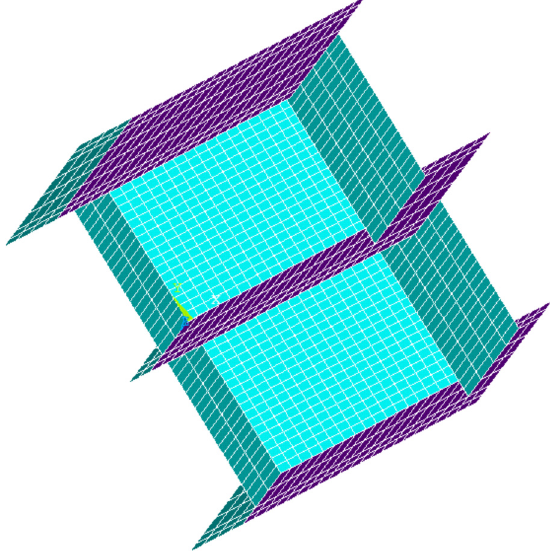
Figure 2. A schematic view of FE